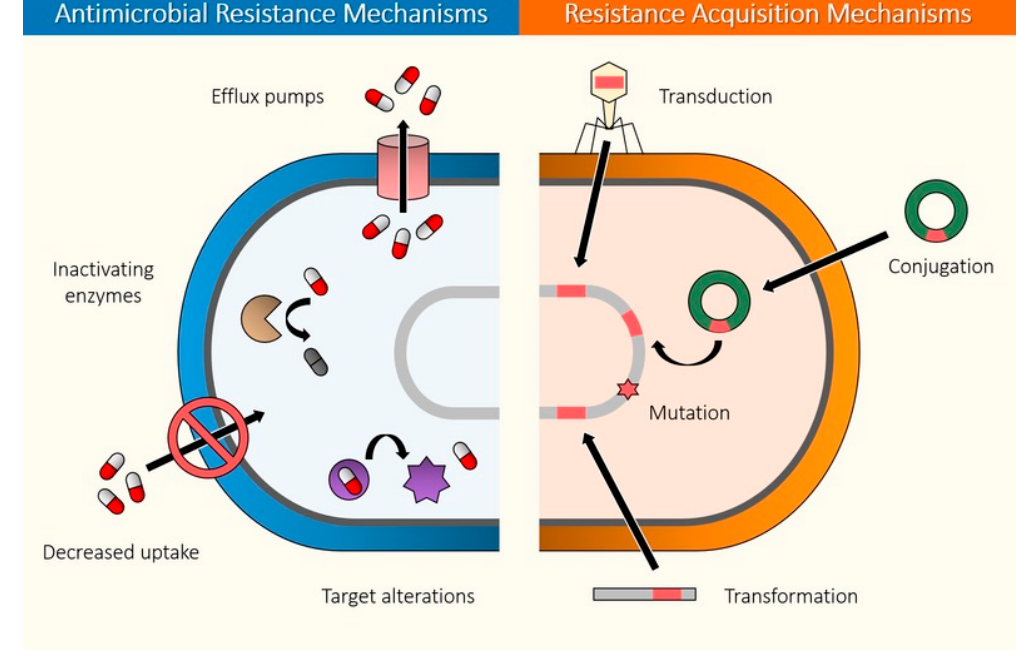
Figure 5. Antimicrobial resistance mechanisms and acquisition mechanisms in bacteria.